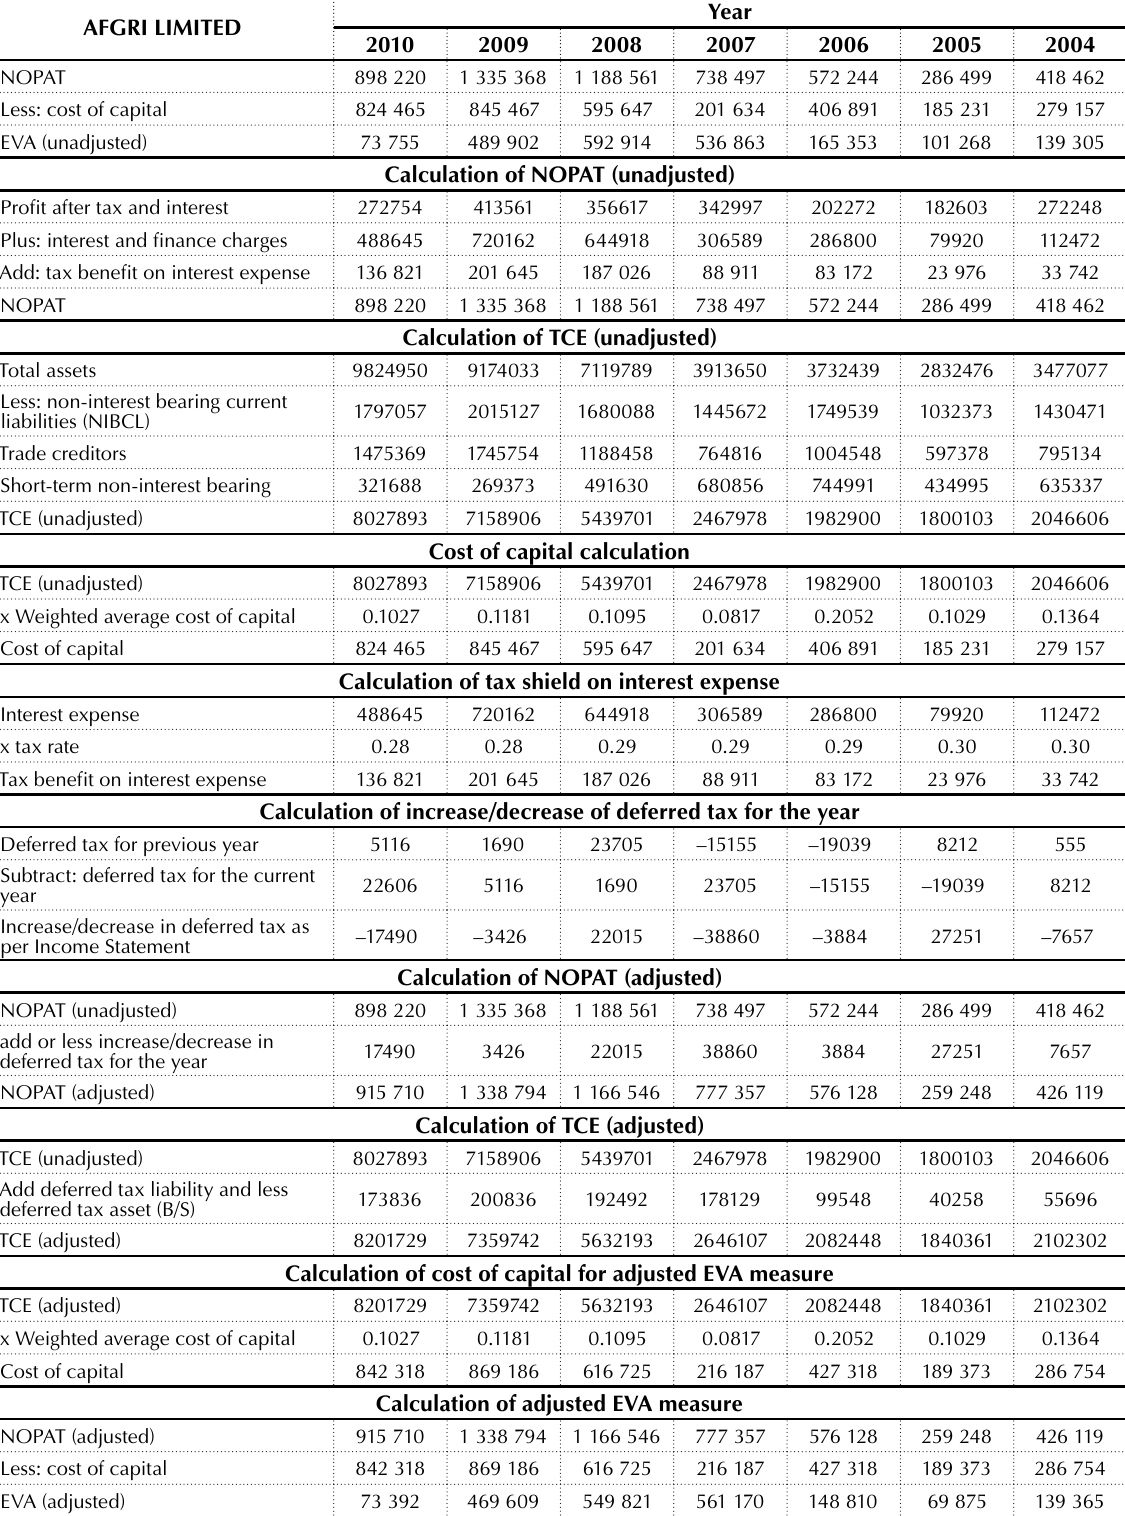
Table A1. EVA and deferred tax analysis (sample company: AFGRI